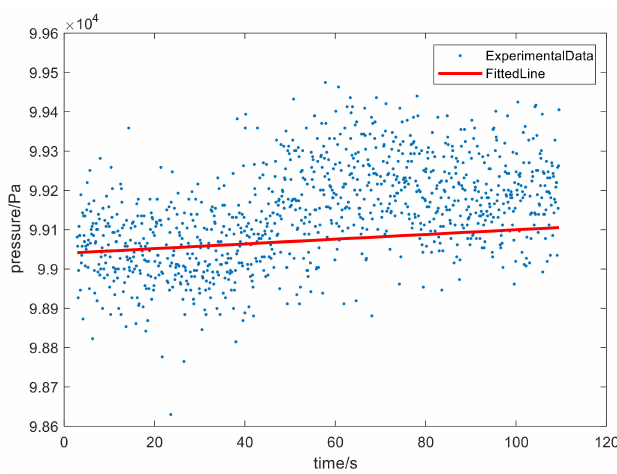
Figure 20. Measured data and fitting curve of pressure sensor 1.